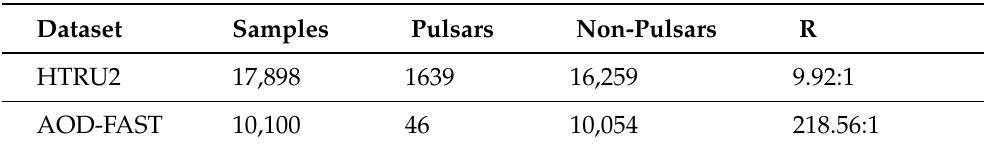
Table 3. Basic information of both datasets used in this study. R is the class imbalance ratio of non-pulsars to pulsars.